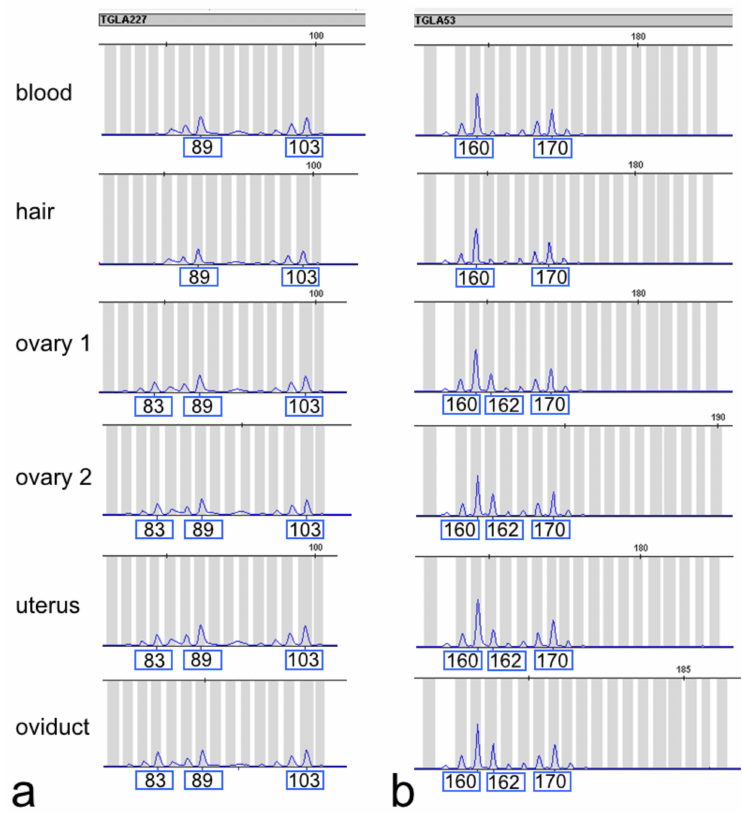
Figure 5. Genotypes for selected microsatellite markers in different tissues of DSD heifer #7514: TGLA227 ( a ) and TGLA53 ( b ). Three size variants for TGLA227 (83, 89 and 103 bp) and TGLA53 (160, 162 and 170) in internal genitalia, instead of two variants observed in blood cells and hair follicles, are